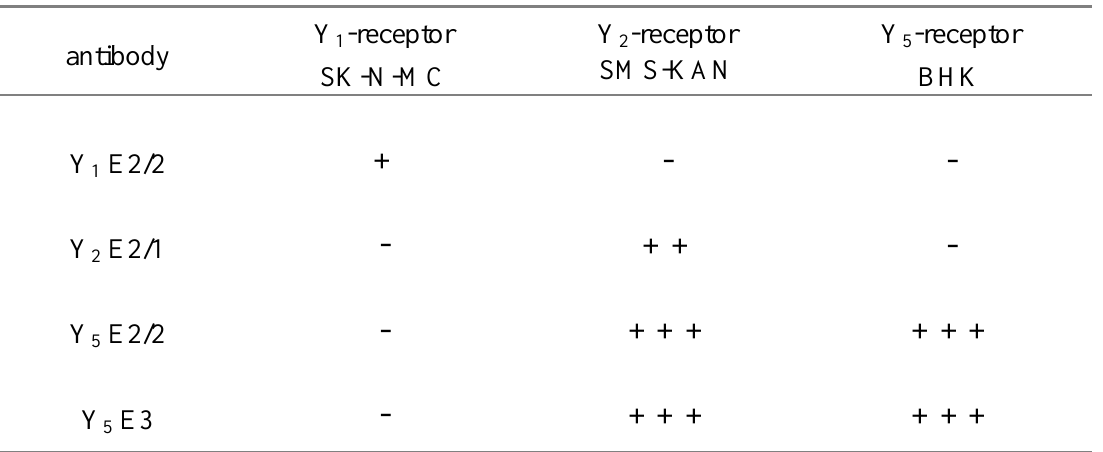
Fluorescence microscope detection of Y-receptors on SK-N-MC cells (neuroblastoma, hY ), SMS-KAN cells (neuroblastoma, hY 1 rY 5